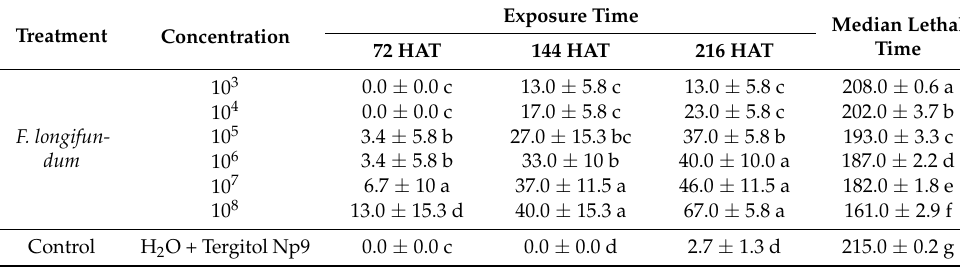
Table 7. Mean mortality ( ± sd) and Median Lethal Time of H. armigera adults exposed to F. pseudoan- thophilum for 216 h of two season experiments. Means of the same column followed by the same letter are not significantly different (Tukey test, a = 0.05), Median Lethal Time (hours ± sd) was estimated by the Kaplan–Meier method (F = 2.678, df = 6, p < 0.001), HAT: Hours After Treatment. Exposure Treatment Concentration